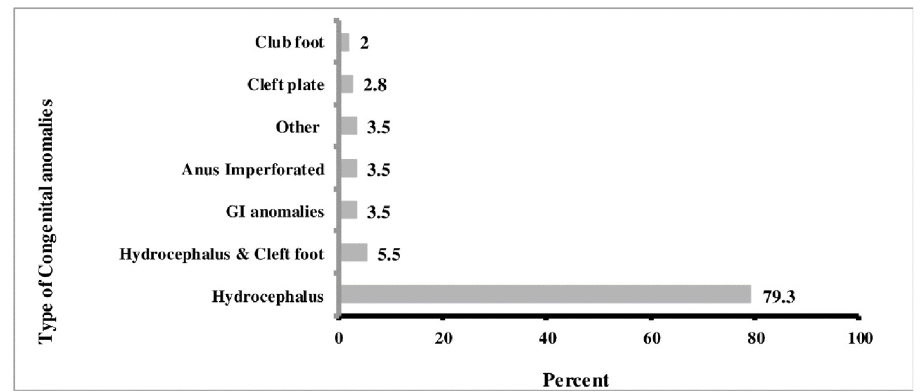
Fig 3. Type of congenital anomalies associated with NTDs Eastern Ethiopia, data from 2017–2019.